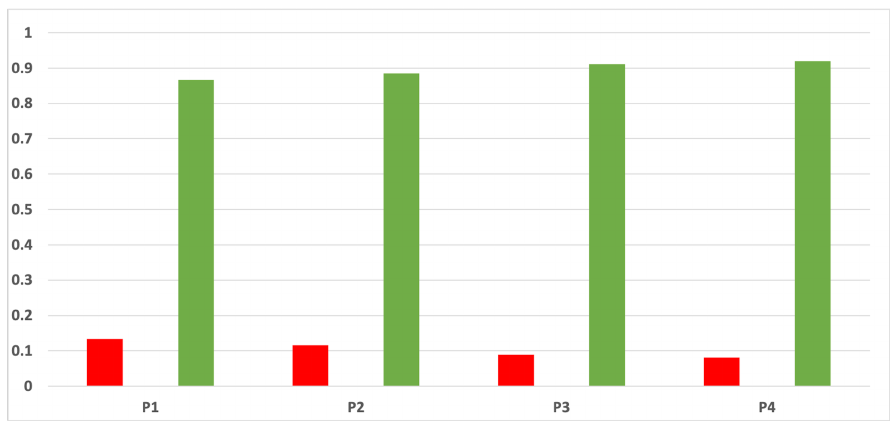
Figure A12. Cont